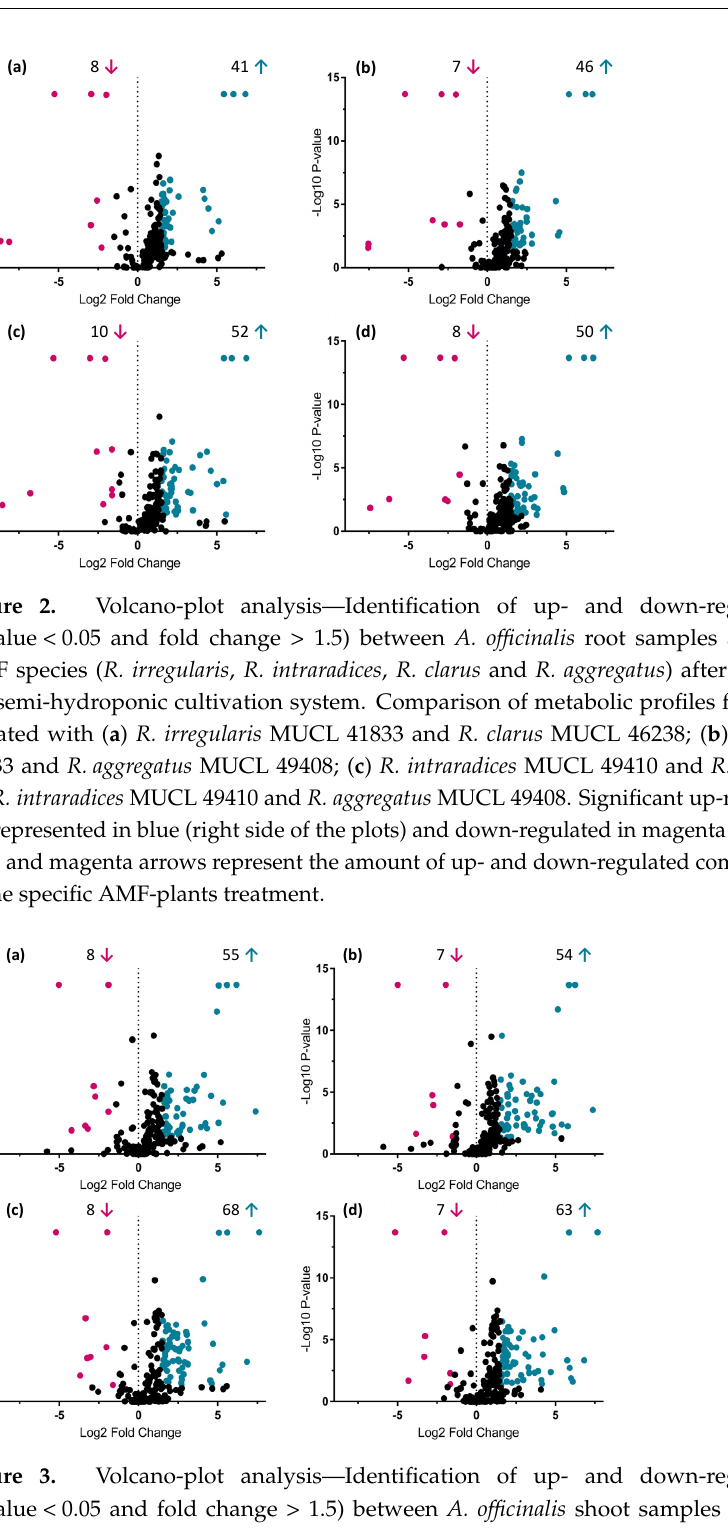
Figure 3. Volcano-plot analysis—Identification of up- and down-regulated compounds ( p -value < 0.05 and fold change > 1.5) between A. officinalis shoot samples associated with four AMF species ( R. irregularis , R. intraradices , R. clarus and R. aggregatus ) after 9 days of growth in the semi-hydroponic cultivation system. Comparison of metabolic profiles from shoot samples associated with ( a ) R. irregularis MUCL 41833 and R. clarus MUCL 46238; ( b ) R. irregularis MUCL 41833 and R. aggregatus MUCL 49408; ( c ) R. intraradices MUCL 49410 and R. clarus MUCL 46238; ( d ) R. intraradices MUCL 49410 and R. aggregatus MUCL 49408. Significant up-regulated compounds are represented in blue (right side of the plots) and down-regulated in magenta (left side of the plots). Blue and magenta arrows represent the amount of up- and down-regulated compounds, respectively, in specific AMF-plants